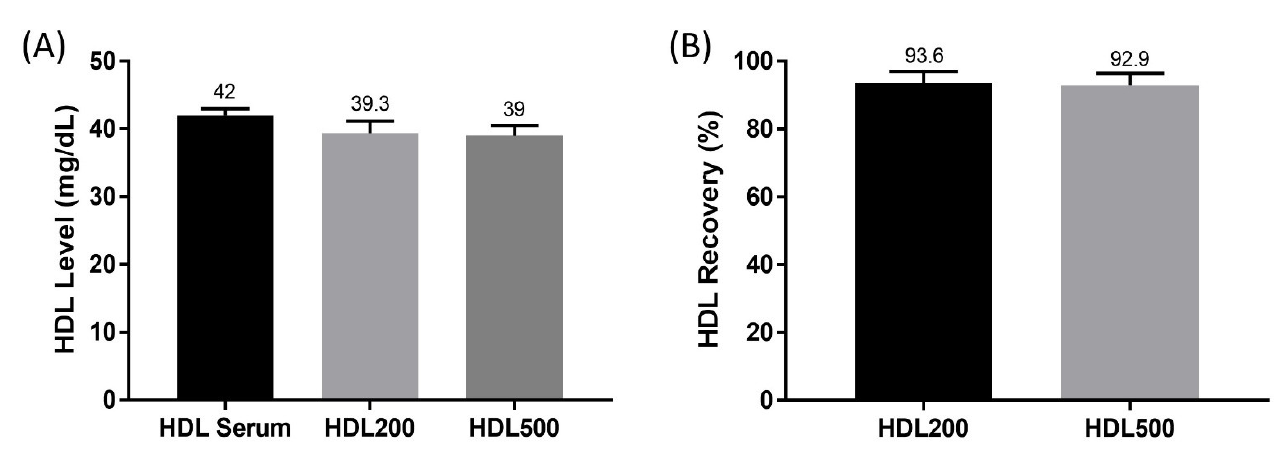
Figure 1. HDL isolation results. HDL was isolated using an HDL purification kit (Cell Biolabs) and measured by a chemistry autoanalyzer. Data of the HDL level ( A ) and the percent recovery ( B ) are the means of three independent experimental replicates ( ± SEM). An independent t -test revealed no significant difference between HDL200 and HDL500 in terms of the HDL level and percent recovery ( p > 0.05).